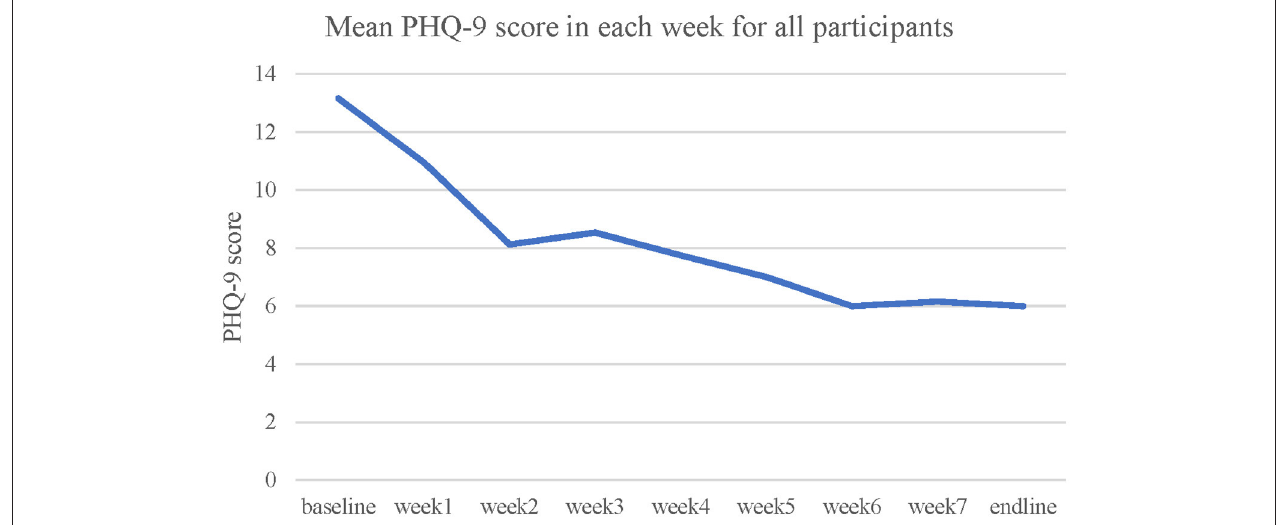
FIGURE 3 | Mean PHQ-9 score in each week for all participants across 8 weeks.